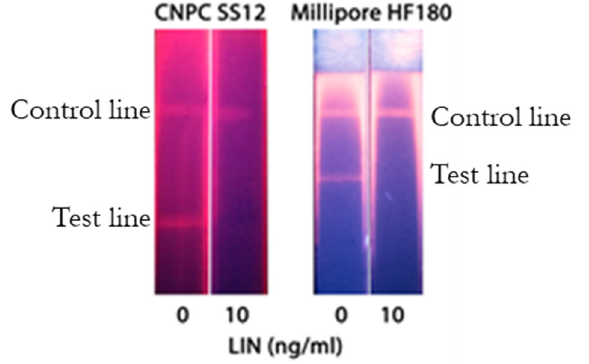
Figure 4. Images of the test zones after the LFIA performed using CNPC SS12 and Millipore HF180 membranes. The LIN-BSA conjugate concentration was 0.15 mg/mL.